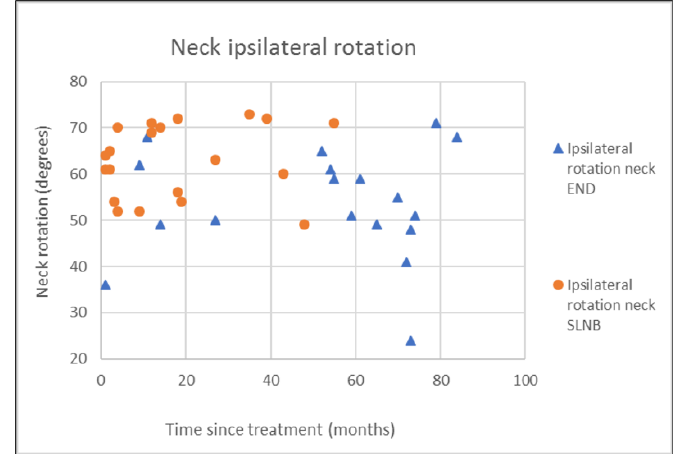
Figure 8. Neck ipsilateral rotation in relation to time since treatment.